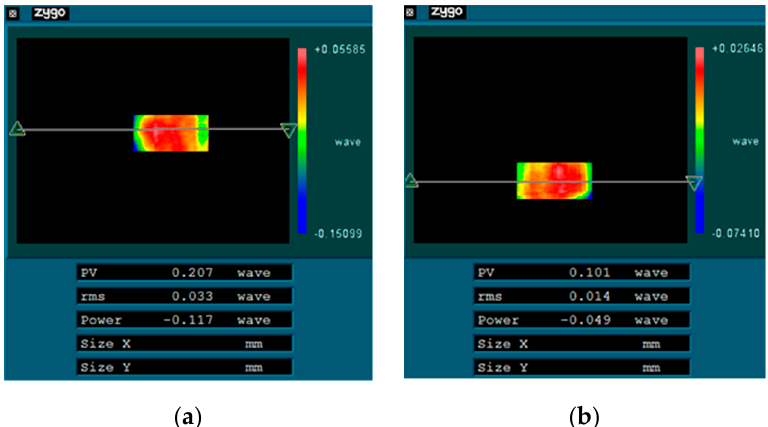
Figure 17. Wavefront comparison of 600 g/mm conventional grating before and after error compen- sation: ( a ) no error compensation; ( b ) with error compensation.